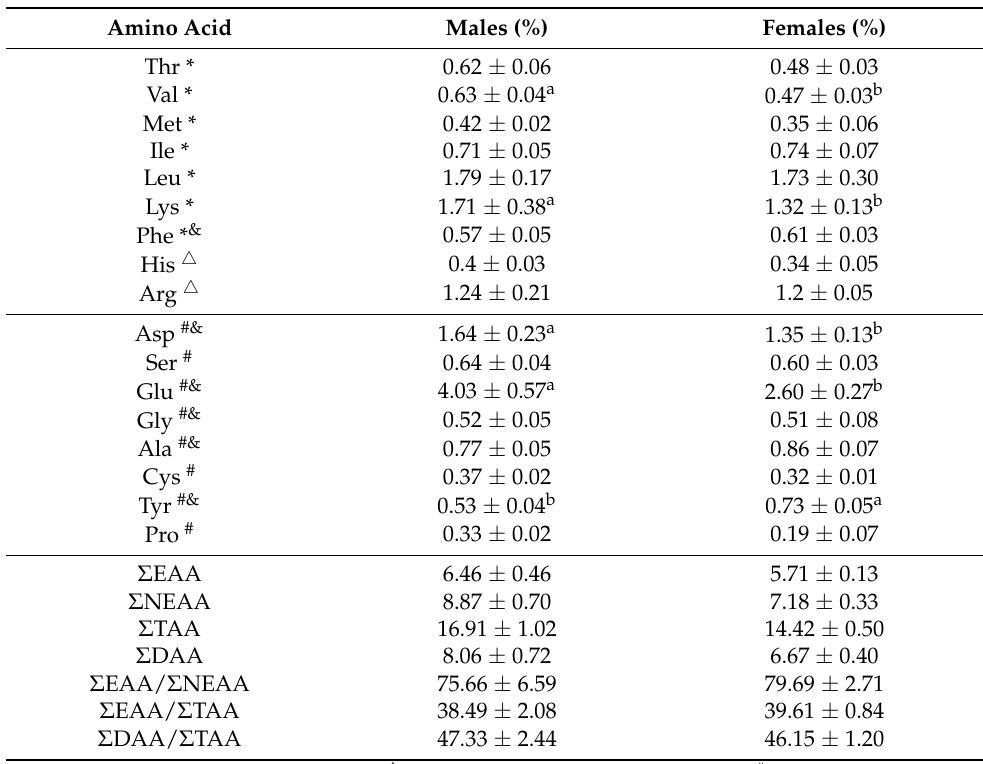
Table 2. Analysis of amino acid composition in the muscles of C. quadricarinatus with different sexes (dry matter; N =